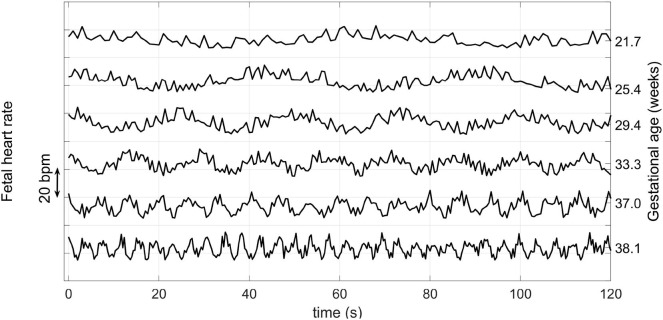
Variation of the FHR from 22 to 38 weeks during pregnancy. Note that the vertical axis has an arbitrary offset. Average FHR does not drop by such a large amount each week during pregnancy, but rather it drops on average by about 15 BPM from week 25 to 40 (Kapaya et al., 2018). Adapted from Wakai (2004).